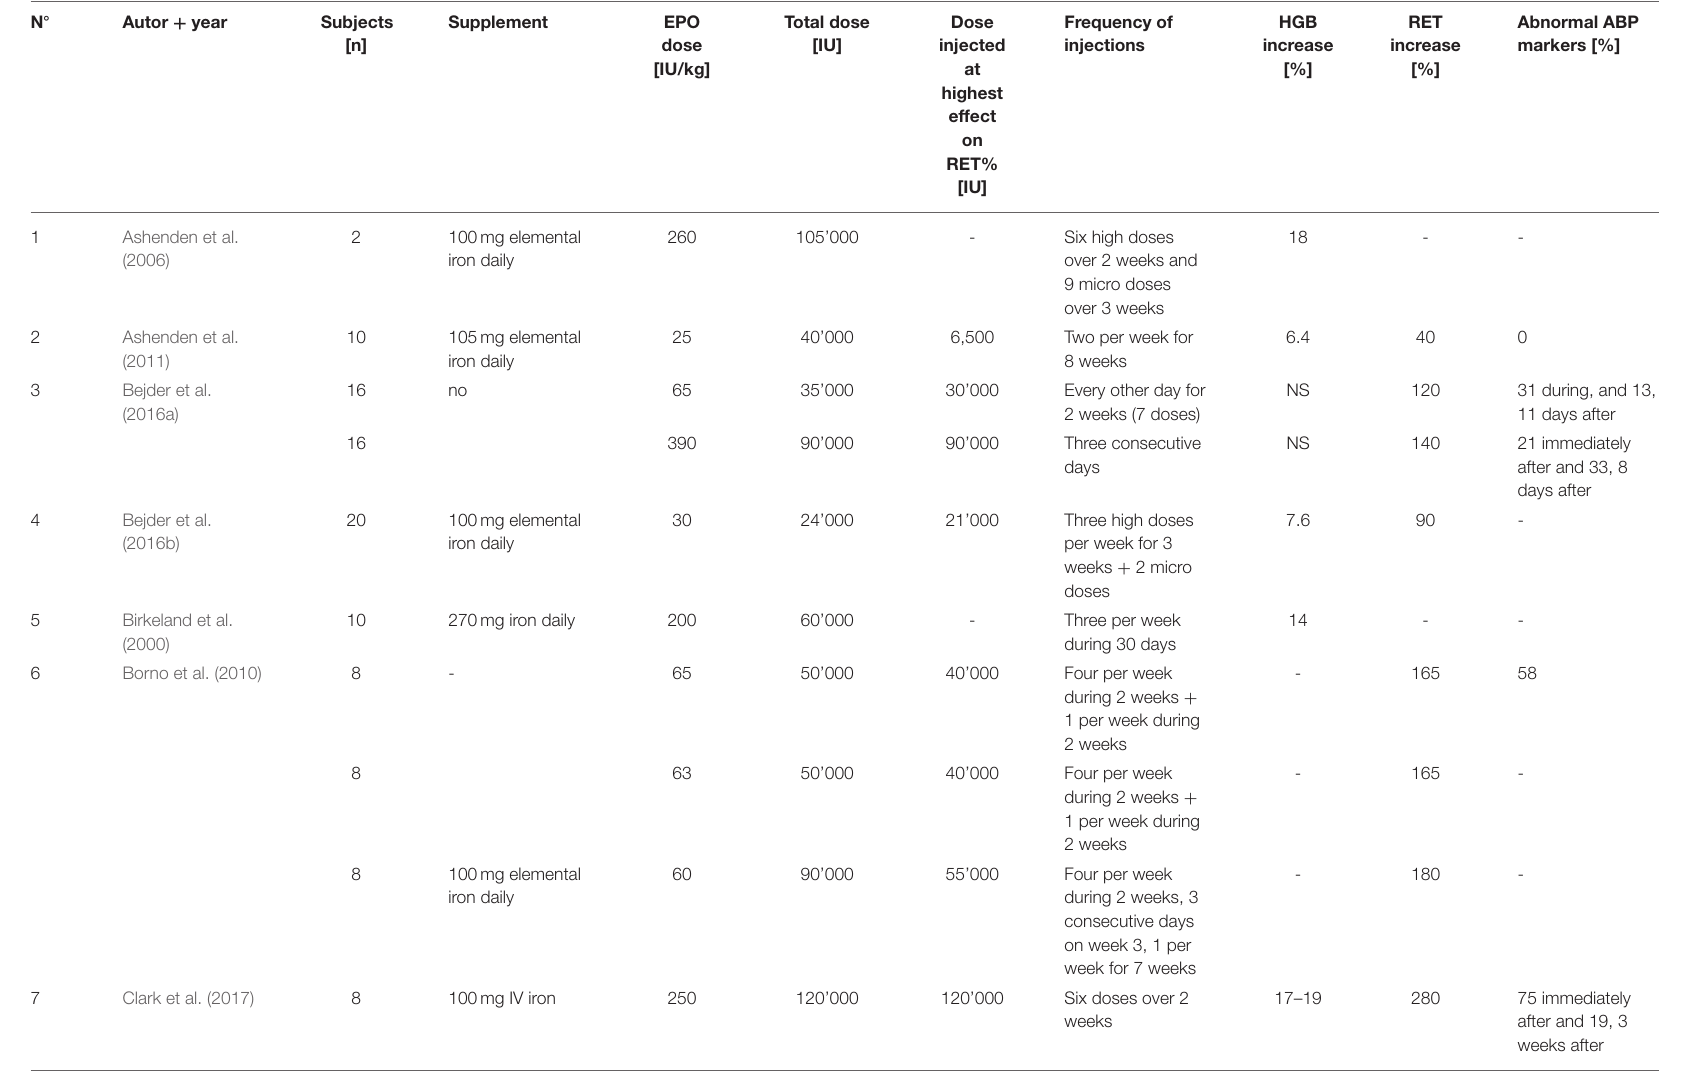
TABLE 2 | Summary of the main physiological parameters collected in the 17 EPO studies of the literature